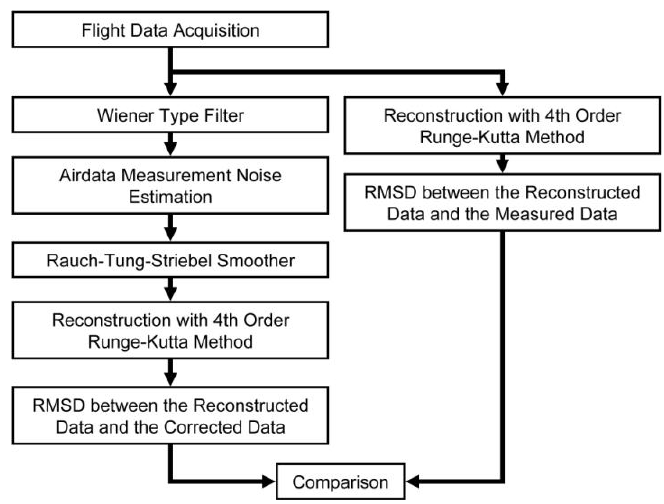
Figure 8. The compatibility correction